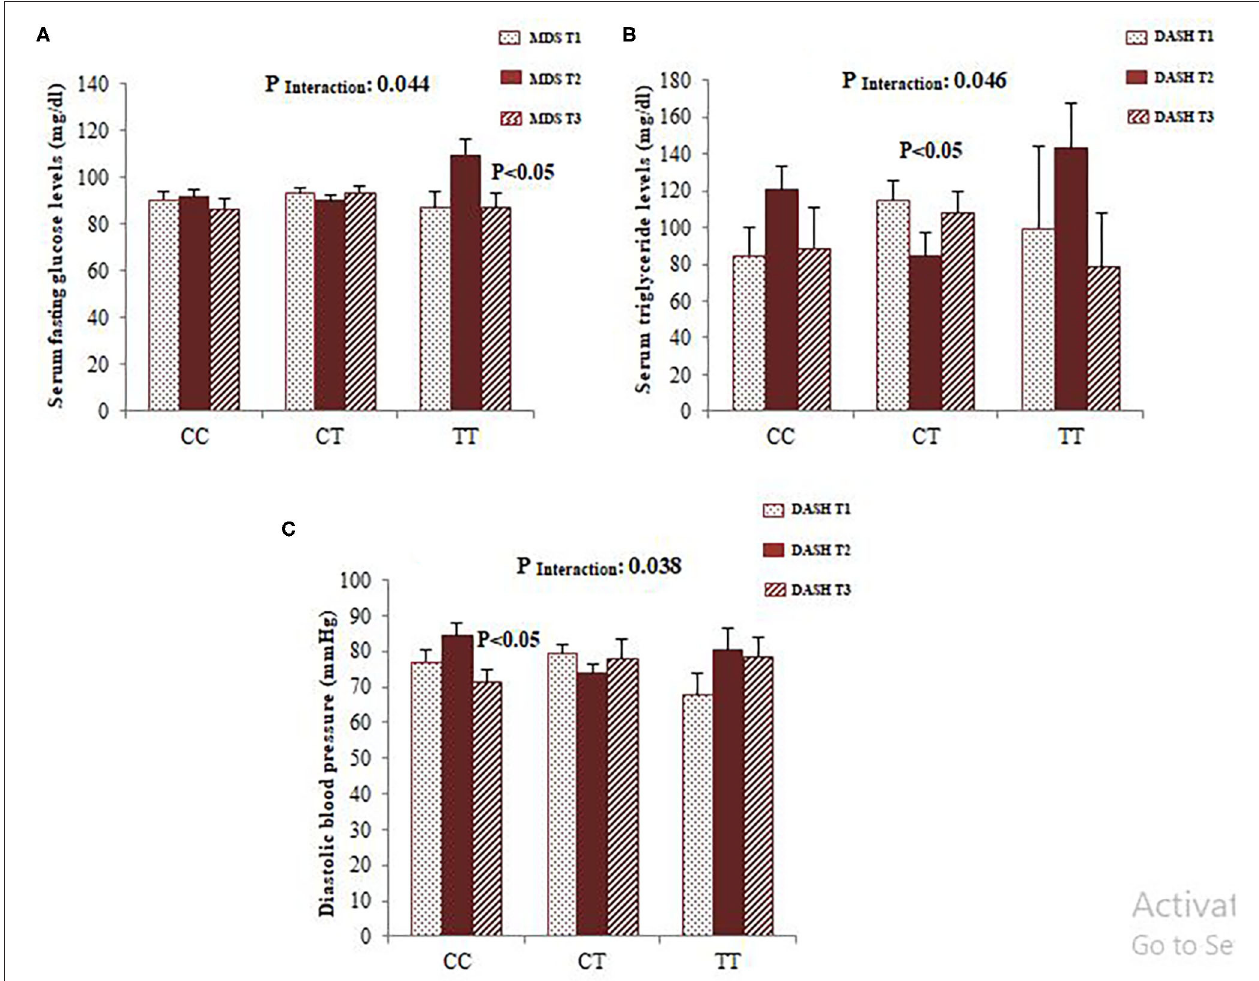
FIGURE 2 | Interaction between FADS2 rs174583 and MDS on the serum concentration of glucose (A) and interaction between FADS2 rs174583 and DASH score on the serum concentration of triglyceride (B) among women. Interaction between FADS2 rs174583 and DASH score on DBP among men (C) . The bars indicate mean. Error bars: SE of means. P -values of interactions were adjusted for age, WC, physical activity, and socio-economic